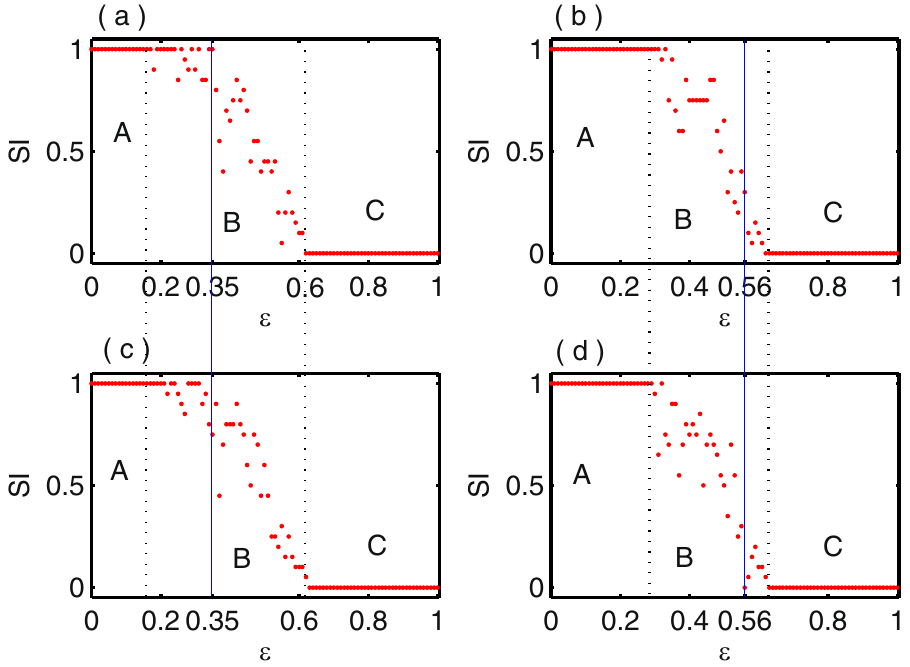
Figure 3. Strength of incoherence is plotted with respect to the coupling strength  for fixed coupling radius R = 0.3 and N = 100. ( a ) and ( c ) show the variation of strength of incoherence for different initial conditions at c = 0.001 and c = 0.03 corresponding to the spatiotemporal scenarios in Fig. 1(a,b,c) and (d,e,f) respectively. A solid blue line is drawn through the coupling strength  = . 0 35 , along the blue line SI takes the values ‘1’ in (a) where in ( c ) the values of SI lies between ‘0’ and ‘1’. In ( b ) and ( d ) strength of incoherences are calculated by varying the interaction strength  using the initial condition of Fig. 2(a,b,c) ( c = 0.09) and Fig. 2(d,e,f) ( c = 0.08). At the coupling strength = . 0 56  , a solid blue line is marked and corresponding this particular coupling strength SI ∈ (0,1) in ( b ) and SI takes the values ‘0’ in ( d ). The regions A, B and C are marked as the regions of incoherent, chimera and coherent states